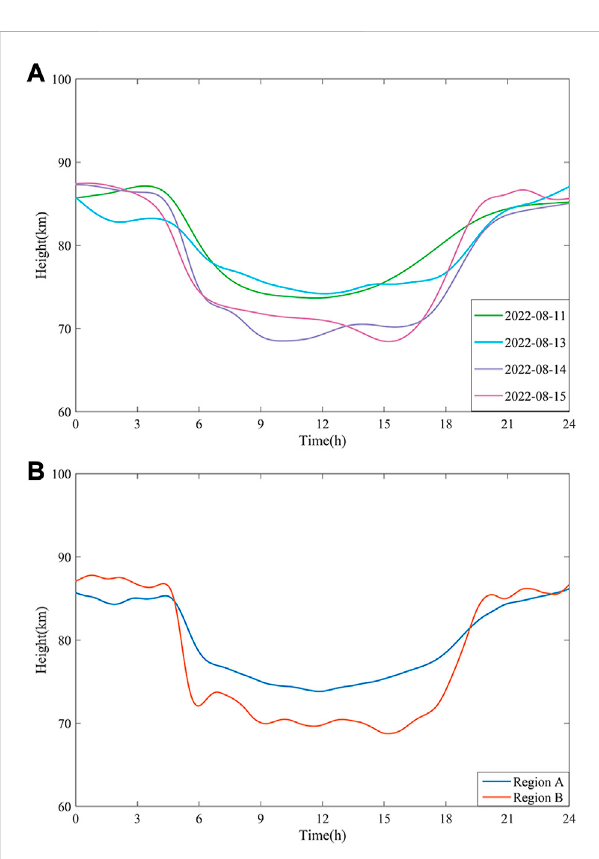
FIGURE 5 Ionosphere equivalent re fl ection height variations of continuous 24 h. (A) On different dates; (B) On different